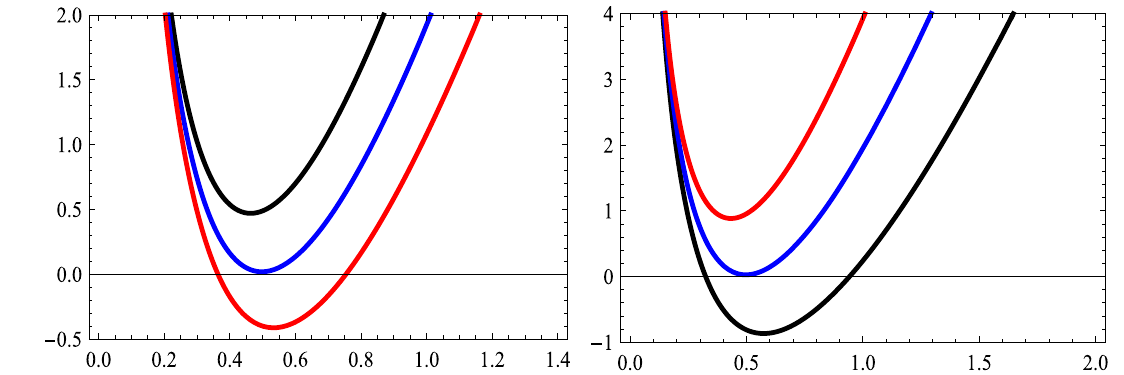
Fig. 1 W ( r ) versus r for b = 1 , α = 2 . 2 , r 0 = 1 , m = 10 , (cid:18) = − 1 , q = 1. Left: ν = − 0 . 37 and a = 1 . 26(black) , 1 . 346(blue) , 1 . 44(red). Right: a = 1 . 44 and ν = − 0 . 362(black) , − 0 . 376(blue) , − 0 . 385(red)